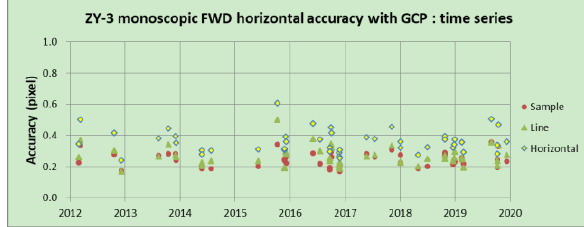
Figure 10. ZY-3 monoscopic FWD horizontal accuracy